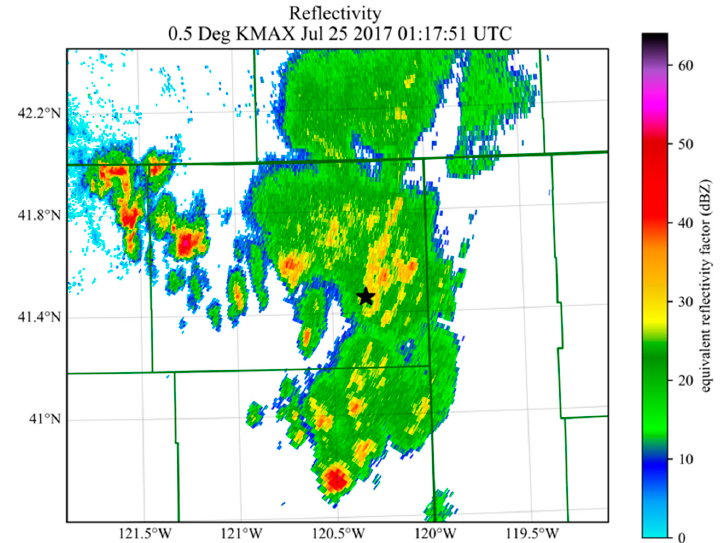
Figure 6. Base reflectivity (dBZ) from the WSR-88D radar in Medford, OR showing the storm system passing over northeast California that caused the Parker 2 Fire [45]. The black star denotes the satellite-derived fire start location nine days later. The time shown is near the time of one of the FS strokes’ discharge.